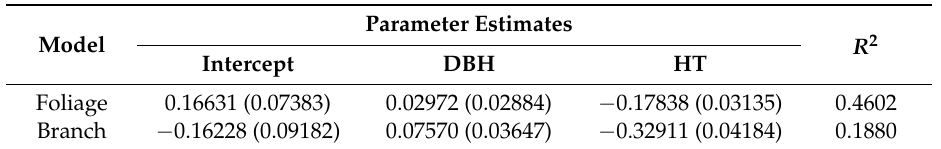
Table 5. Parameter estimates for the component biomass models for small DBH trees using Dirichlet regression. Component stem biomass was used as the reference group.